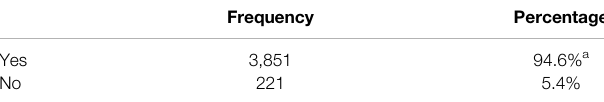
TABLE 7 | Faculty and students ’ access to information technology (n (cid:1) 4,072).